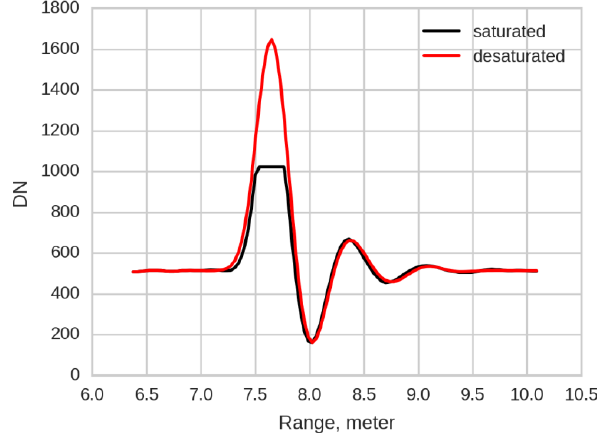
Figure 2. Example of saturated pulse and saturation correction.